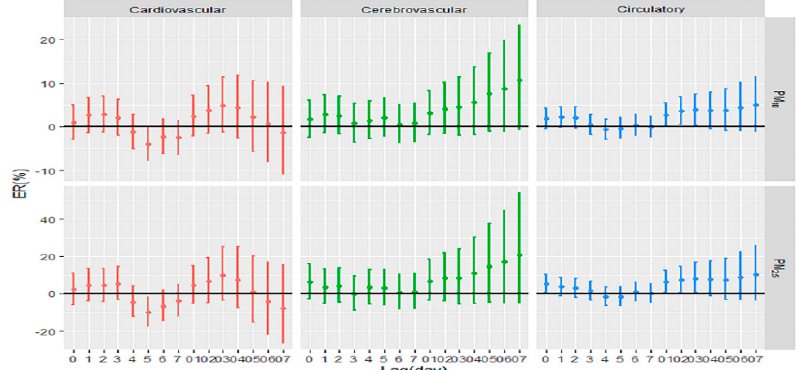
Figure 1. Estimates of percent change in daily circulatory mortality associated with a 10 µ g / m 3 increase in particulate matter concentrations during days with heat waves. Note: PM 10 : particulate matter less than 10 µ m in aerodynamic diameter; PM 2.5 : particulate matter less than 2.5 µ m in aerodynamic diameter; ER: excessive risk. X-axis: lag0 to lag7 means a single-day lag. lag0–1 to lag0–7 means cumulative lag e ff